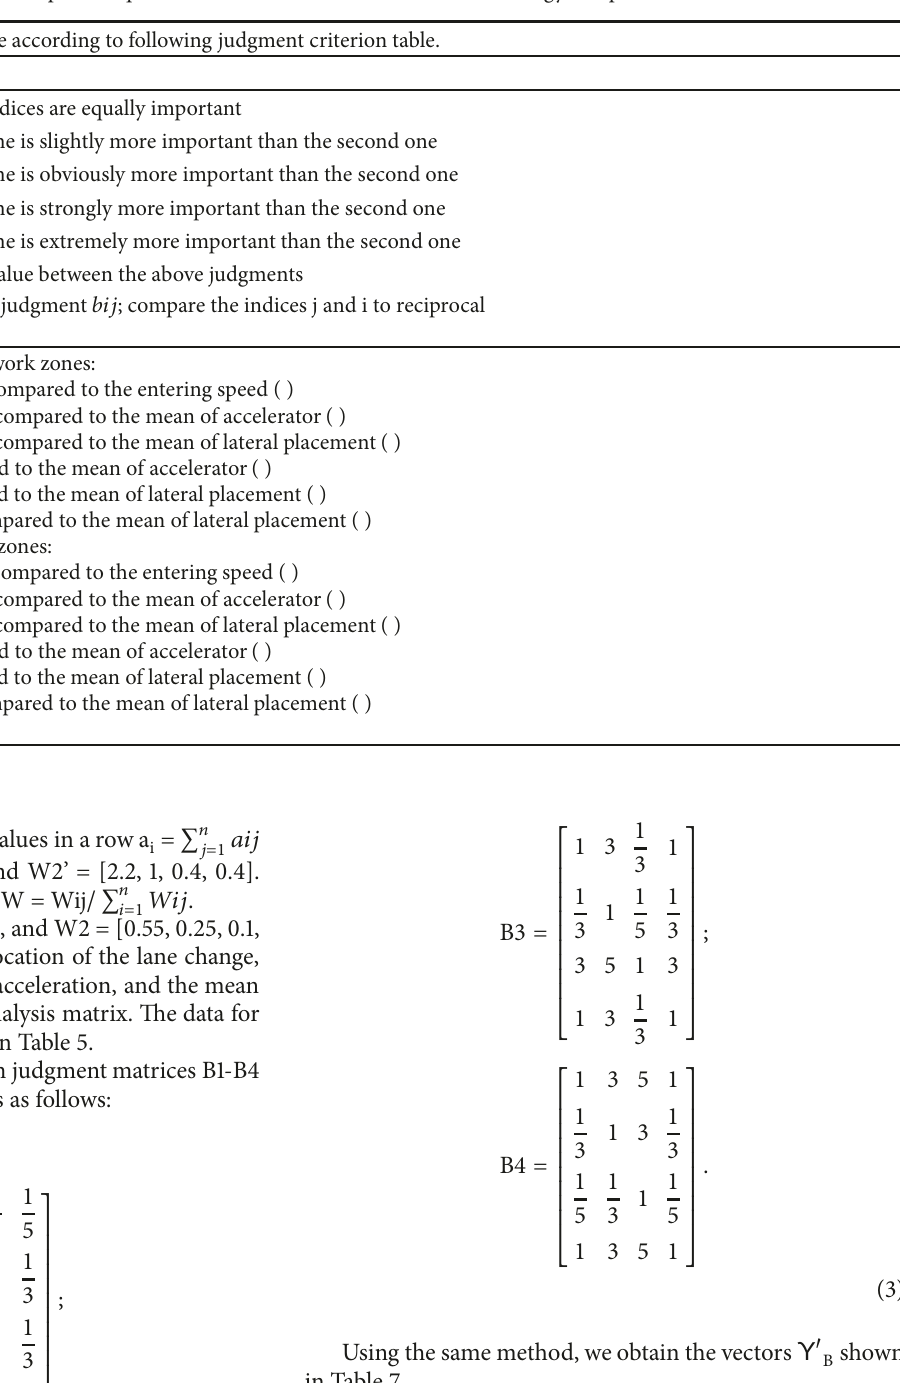
Table 4: Index pairwise comparison questionnaire for the AHP method in the strategy compliance